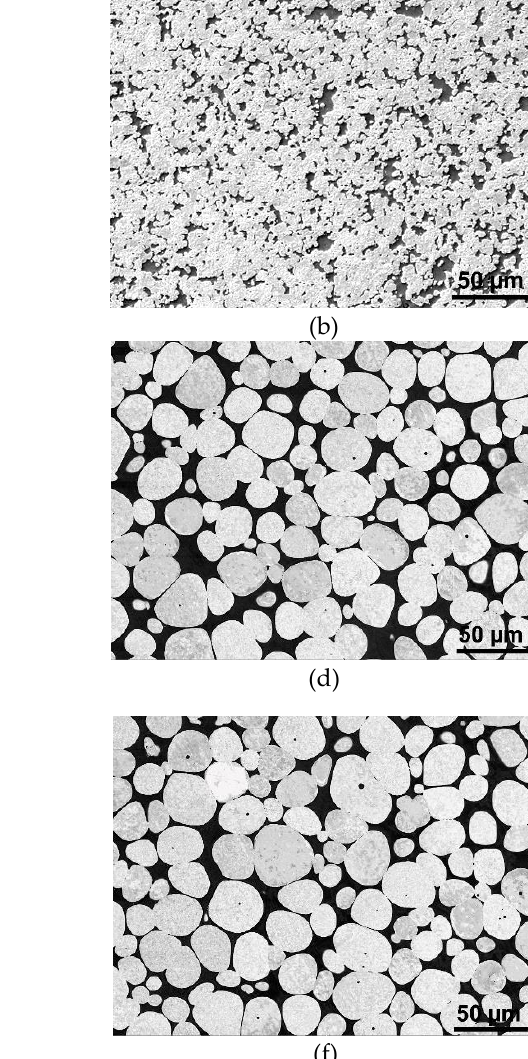
Figure 5. TEM scan showing a W-NiCo-W interface and measured line scan area for sample sintered at 1500 °C for 180 min ( a ); chemical composition of measured line scan ( b ).